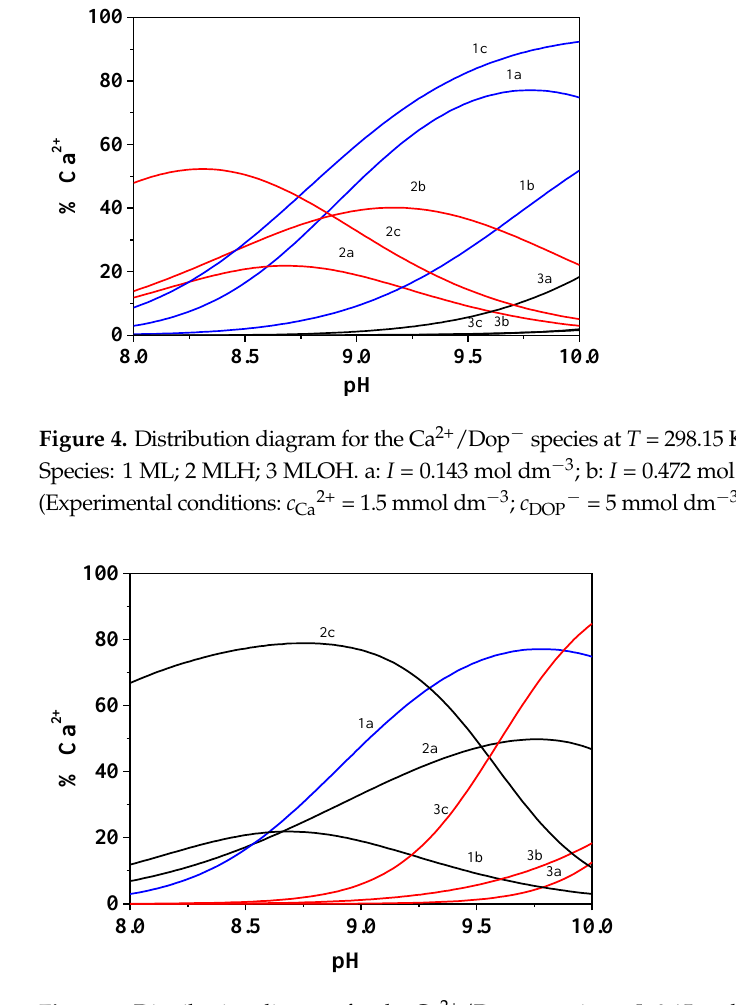
Figure 5. Distribution diagram for the Ca 2+ /Dop − species at I ~0.15 mol dm −3 and different tempera- tures. Species: 1 ML; 2 MLH; 3 MLOH.a: T = 288.15 K; b: T = 298.15 K; c: T = 310.15 K. (Experimental conditions: c Ca2+ = 1.5 mmol dm −3 ; c DOP− = 5 mmol dm −3 ) [M = Ca 2+ ; L = Dop − ]. 3.3.2. Mg 2+ /Dop − System The Mg 2+ /Dop − interactions were investigated at different of ionic strengths ( I range = 0.15–1.0 mol dm −3 ) and temperatures (from T = 288.15 to 310.15 K). The stoichiometry and stability constants of the Mg 2+ /Dop − species were determined following the procedure already reported in the previous sections. The selected speciation model that gave the best results in terms of statistical parameters considers the ML and MLOH species. Table 5 reports the formation constants at different temperatures and ionic strengths in NaCl aqueous solution.